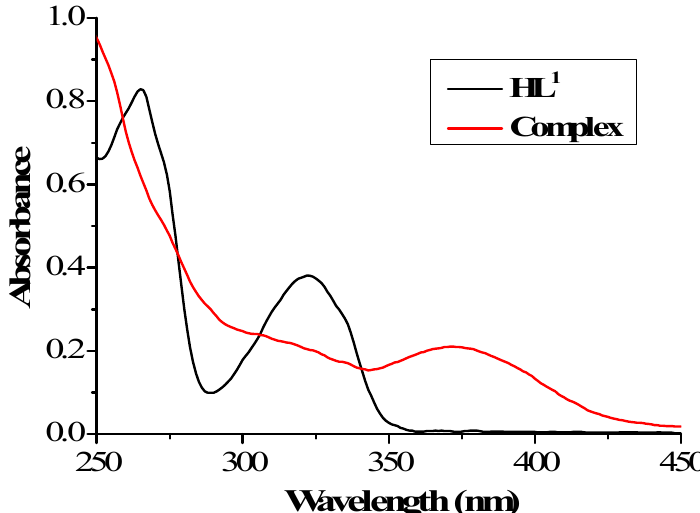
Figure 2. The UV-Vis spectra of HL 1 and the Co(II) complex.